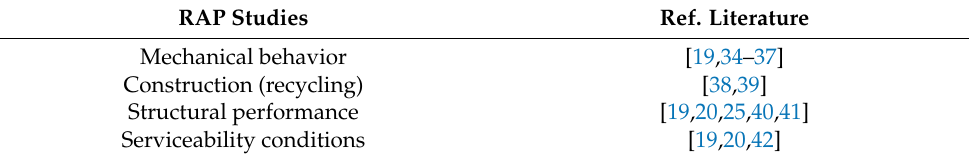
Table 1. Different studies using